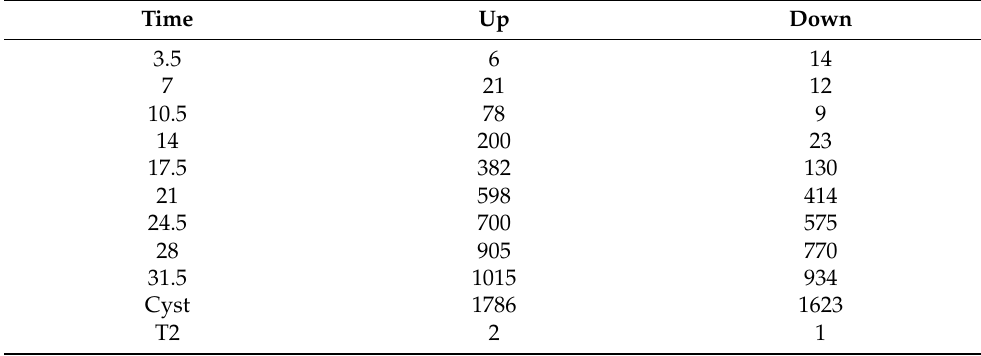
Table 1. Number of DEGs at each timepoint during encystation and excystation of Giardia